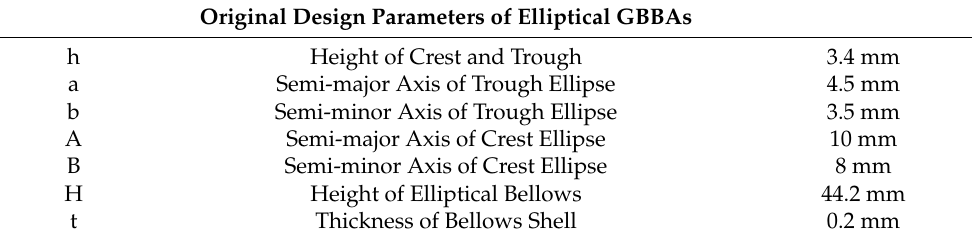
Table 1. Original design parameters of elliptical